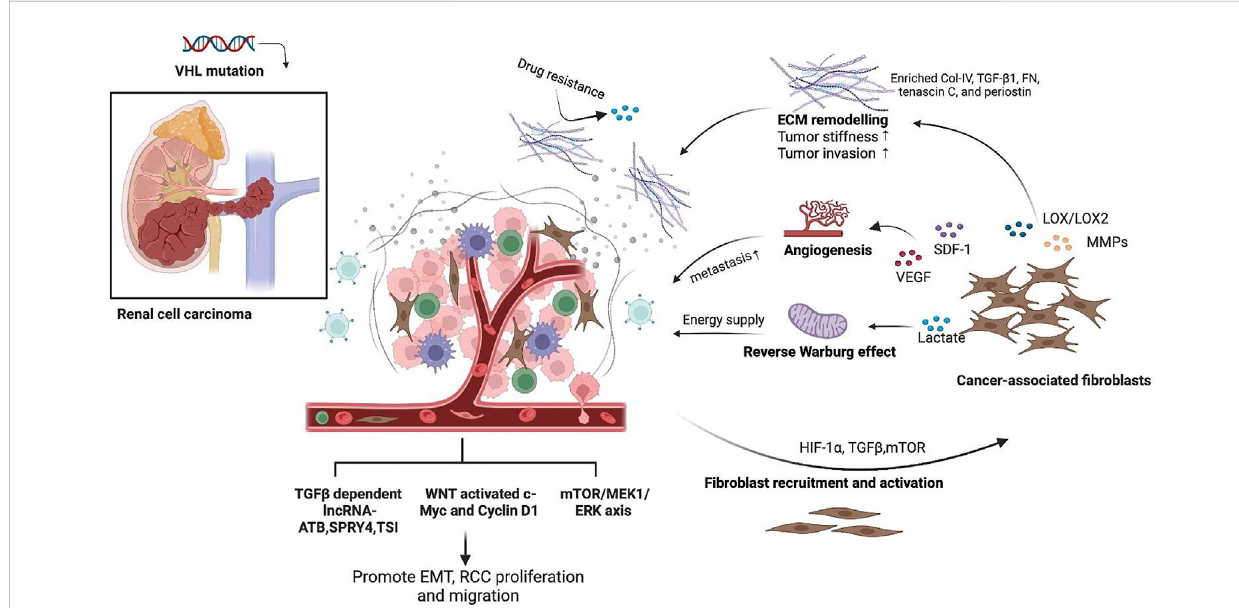
FIGURE 2 Schematicrepresentationoftheroleof fi broticsignalinginrenalcellcarcinoma(RCC).CAFsarethemajorsourceof fi broticstromaintheRCCTME, which could be activated due to HIF-1 α accumulation and TGF- β and mTOR signaling regulation from cancer cells. Activated CAFs secreted MMPs and LOX to promote ECM remodeling with enriched collagen IV, TGF- β 1, fi bronectin, tenascin C, and periostin, thus promoting tumor stiffness, drug resistance, and tumor invasion. CAFs in RCC also produce SDF-1 and VEGF to promote tumor angiogenesis and favor RCC metastasis. CAFs fed cancer cells with increased lactate as a direct energy supply via aerobic glycolysis, which is known as the “ reverse Warburg effect. ” RCC also expressed pro- fi brotic signaling pathways, including TGF- β and its downstream lncRNA, WNT, and mTOR signaling pathways, to mediate the EMT process, tumor cell proliferation, and migration. This fi gure was created in